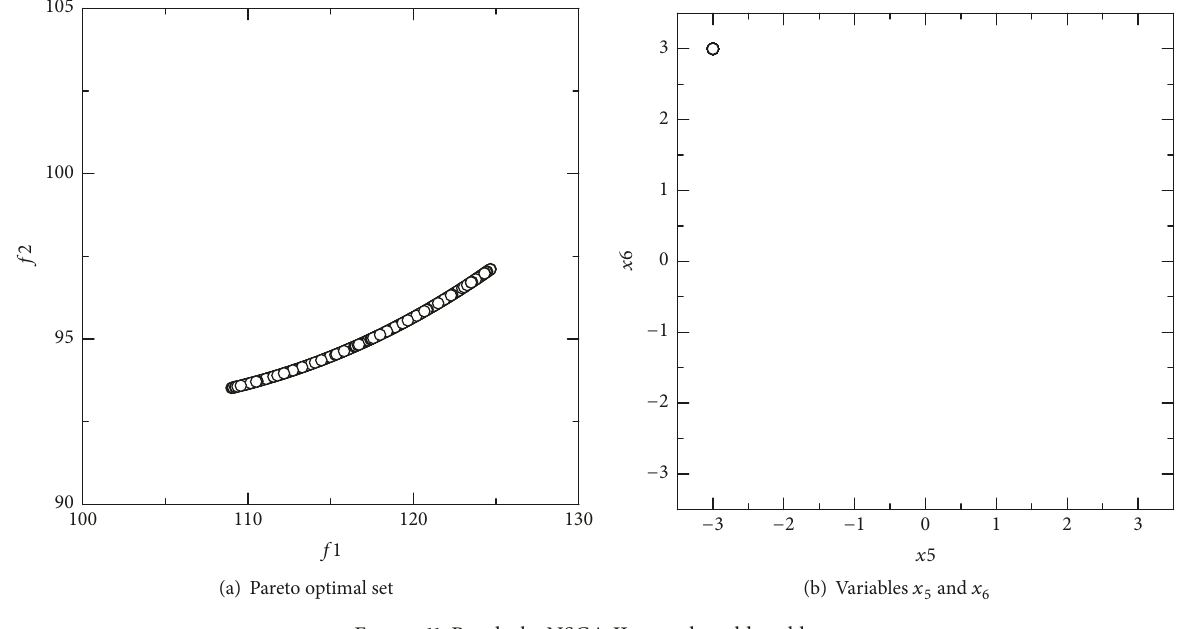
Figure 11: Results by NSGA-II on real world problem.